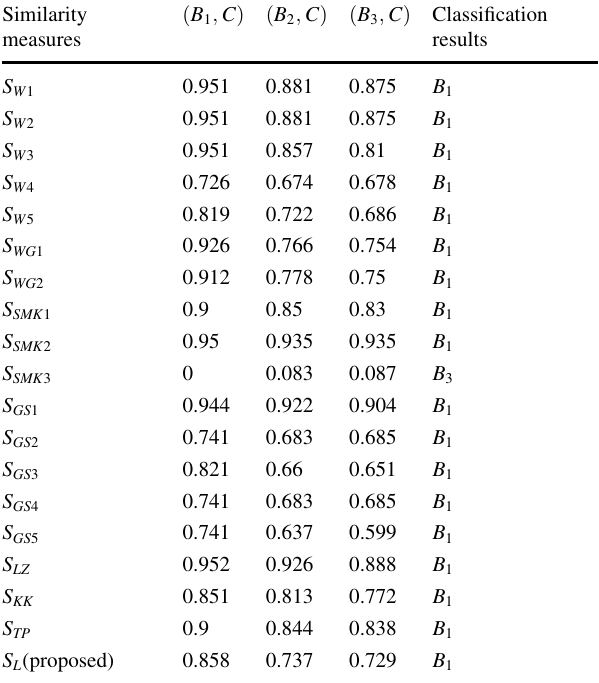
Table 1 Comparison results of PF similarity measure Similarity